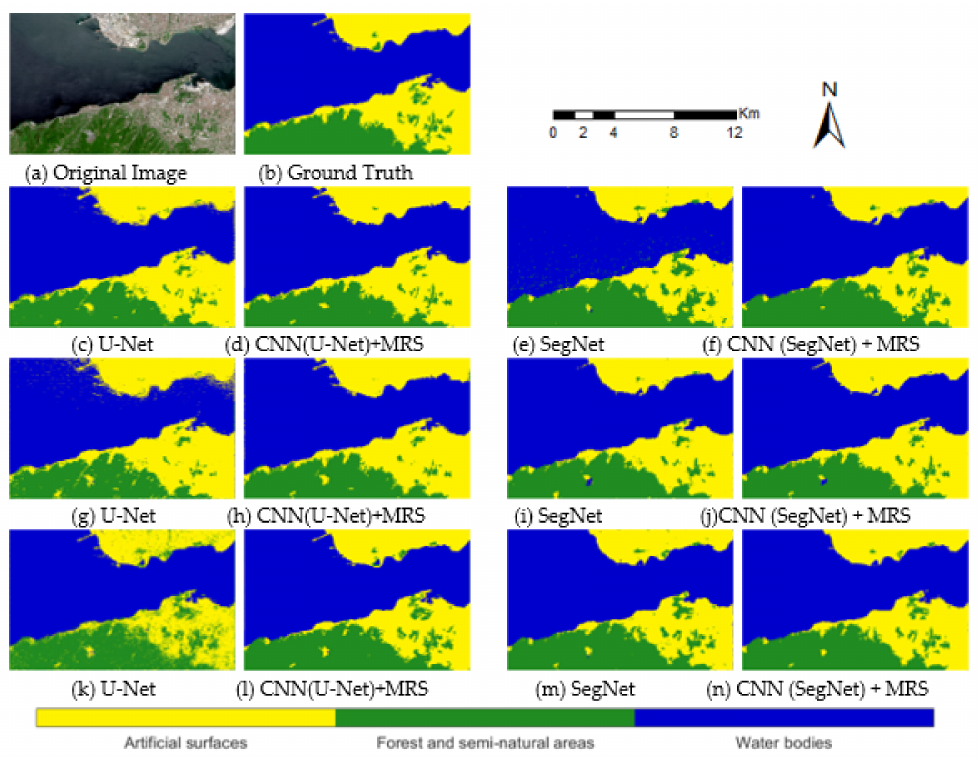
Figure 15. Kocaeli test area results of CNN models and CNN–MRS models with 7-band dataset ( c – f ): 32 × 32 patch size; ( g – j ): 64 × 64 patch size; ( k – n ): 128 × 128 patch